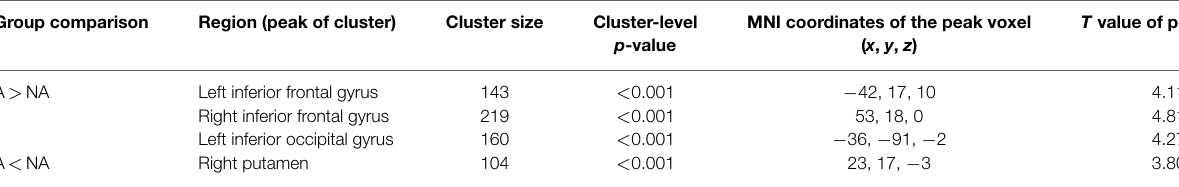
TABLE 2 | Whole brain analysis comparisons of gray matter volume between apathy and non-apathy groups .